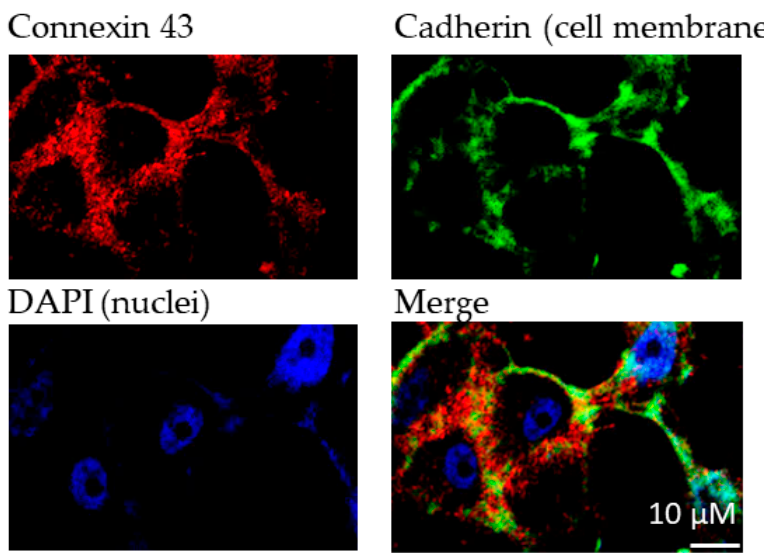
Figure 3. Immunofluorescence analyses of Cx43 expression in transfected HeLa cells. Cadherin was used to stain cell membranes. Primary antibodies (1:1000): antipan cadherin (mouse), anti Cx43 (rabbit); secondary antibodies (1:500): Alexa 488 (antimouse), Alexa 594 (antirabbit). DAPI (1:10,000) was used to stain cell nuclei.